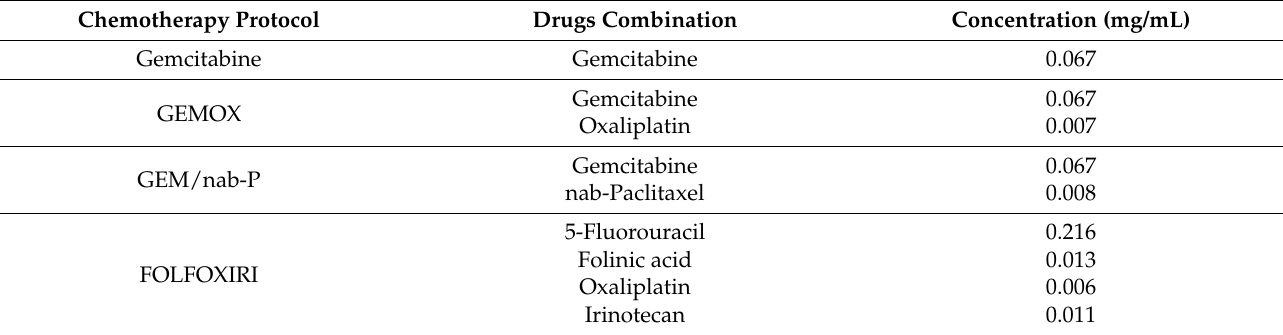
Table 3. Chemotherapy protocols used in the study to assess the therapeutic responses of PDAC zPDXs. The drugs in the combinations and their concentrations are reported.